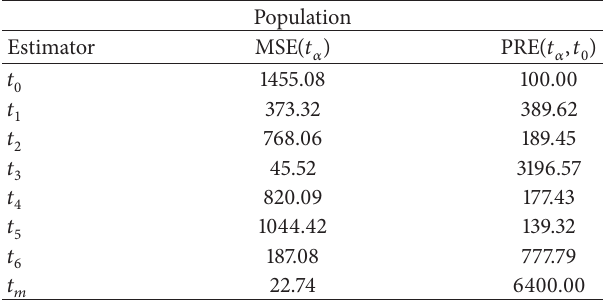
Table 1: The percent relative efficiency of different estimators with respect to 𝑡 0 .